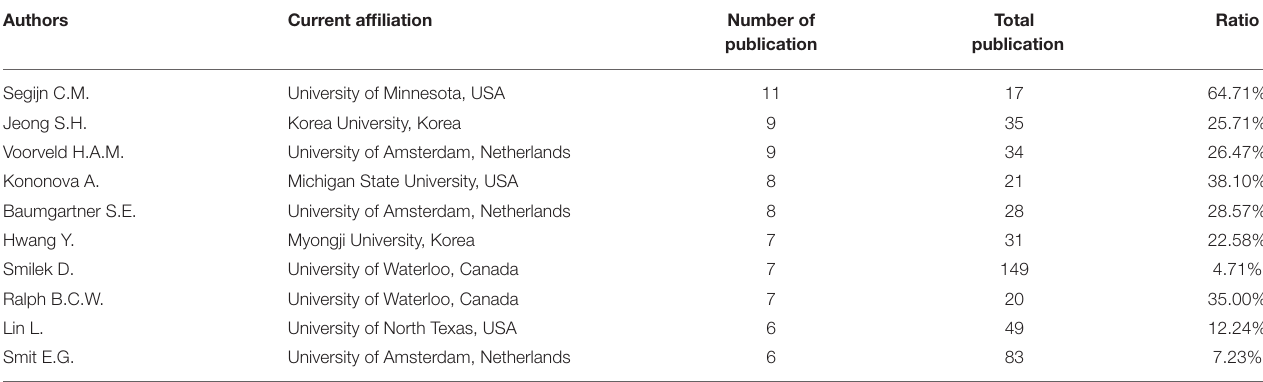
TABLE 2 | The ten most prolific authors contributing to media multitasking